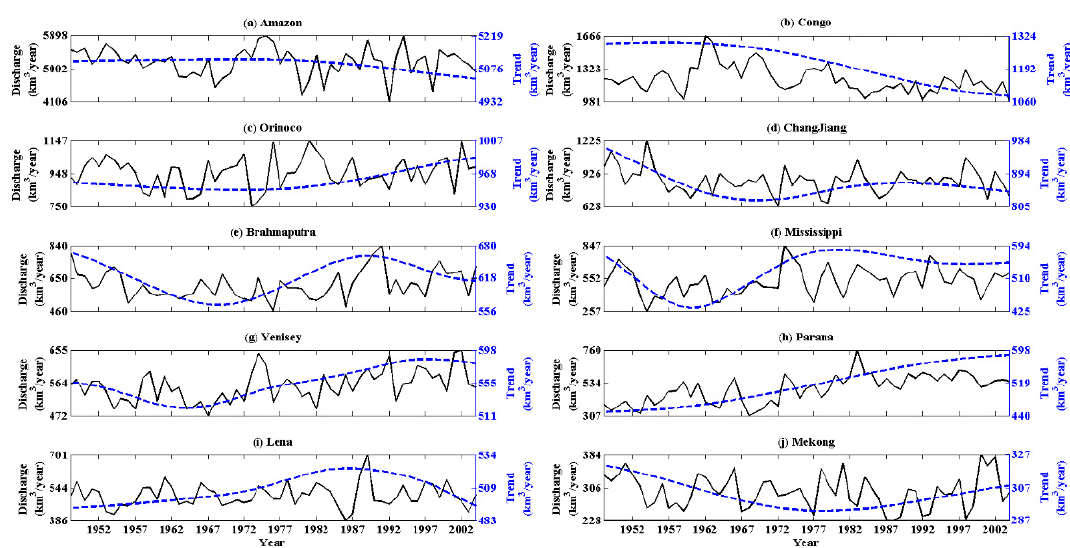
Figure 3. The constructed discharge time series of the 10 largest rivers (black curve) and their trends (blue curve) as estimated using the EEMD method from 1948–2004.